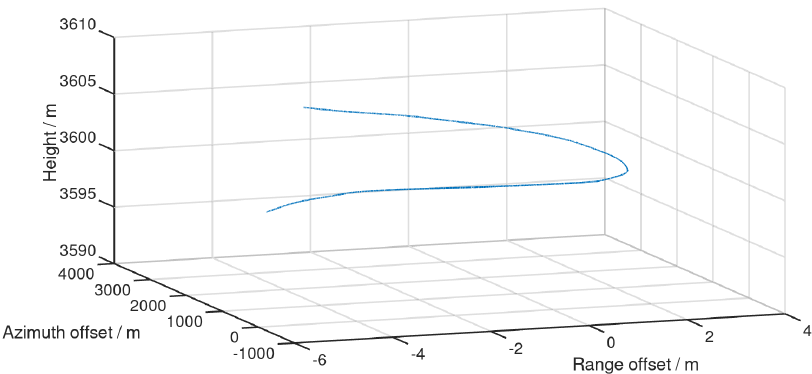
Figure 16. The flighting